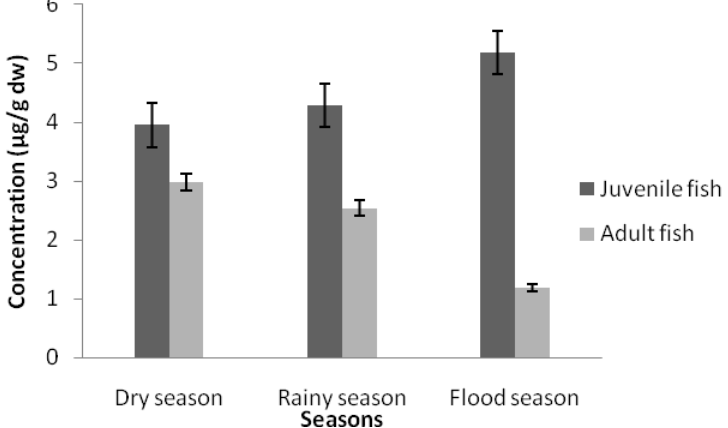
Figure 2. Seasonal variation of cadmium concentrations in muscle tissues of tilapia ( Sarotherodon melanotheron ).